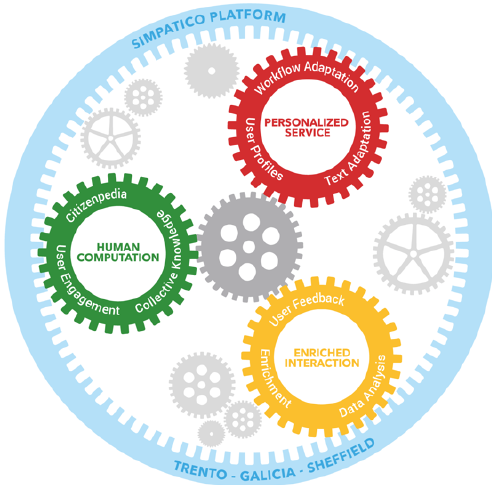
Figure 1. SIMPATICO concept as a